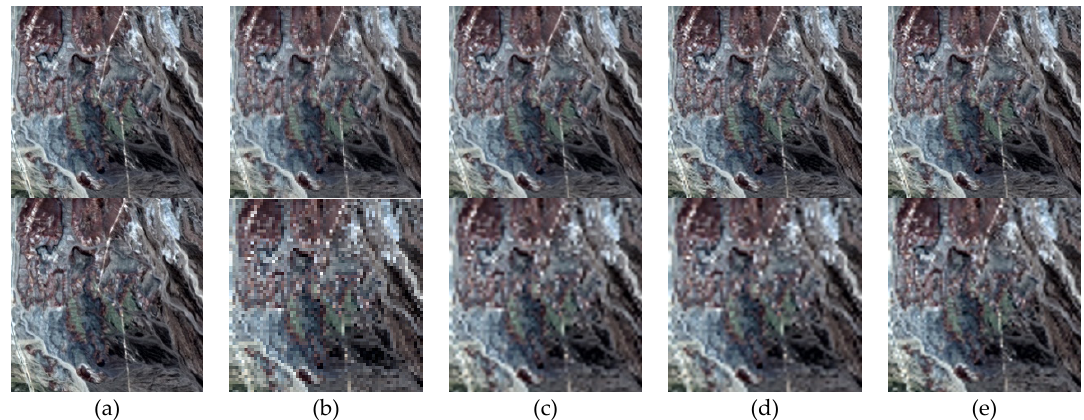
Figure 4. Spatial resolution enhancement comparison on Indian pines dataset, from top to bottom are the comparison with down-sampling factor of 2 and 4. ( a ) Reference HRI, spatial resolution enhancement results of ( b ) GSA method, ( c ) Indusion method, ( d ) SparseFI method and ( e ) Proposed J-SpeSpaRE method (after spectral degradation).